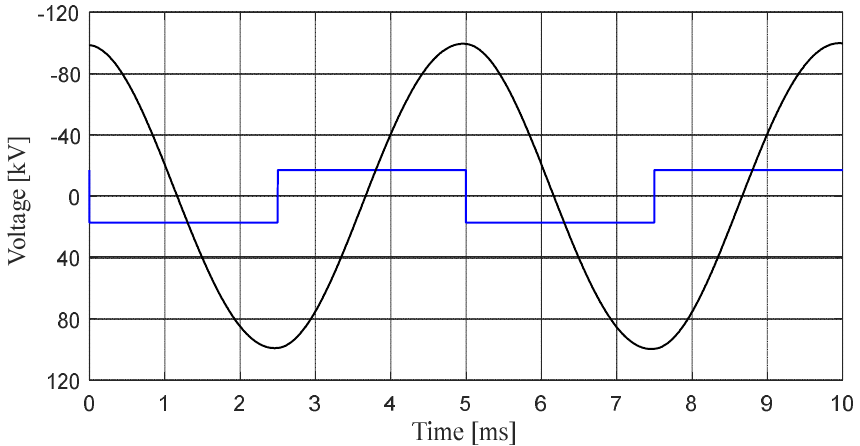
Figure 16. The input and output voltages of the testing transformer (all transferred to the HV side).